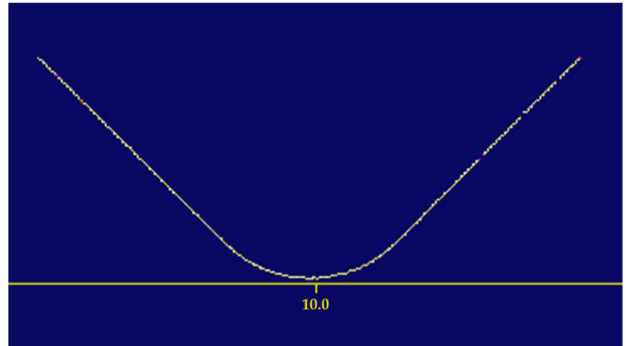
Figure 12. Resultant curve.